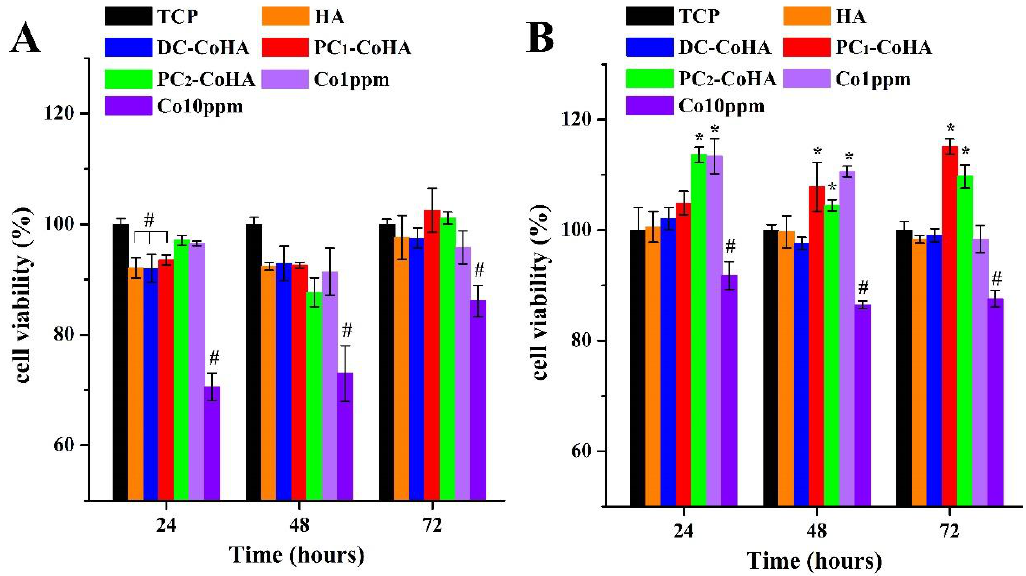
Figure 9. CoHA cytotoxicity test using ( A ) L929 cells and ( B ) MG63 cells, respectively. *: Significantly higher than the control group (TCP). #: Significantly lower than the control group (p < 0.01).